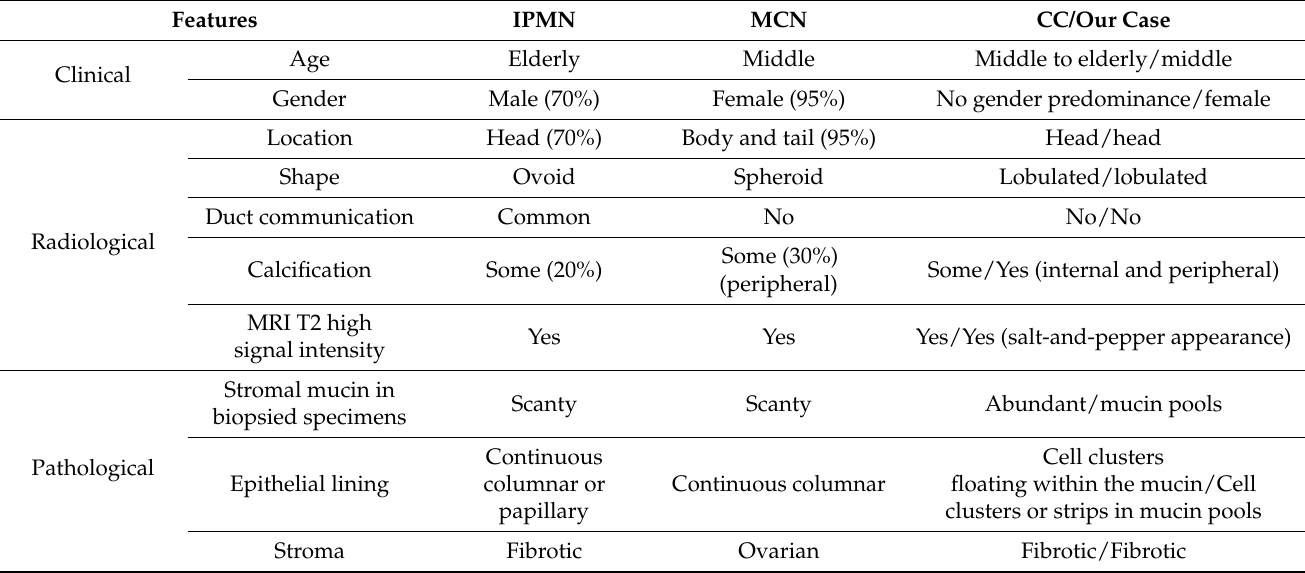
Table 1. Distinguishing clinical, radiological and pathological features of mucin-rich neoplasms of the pancreas